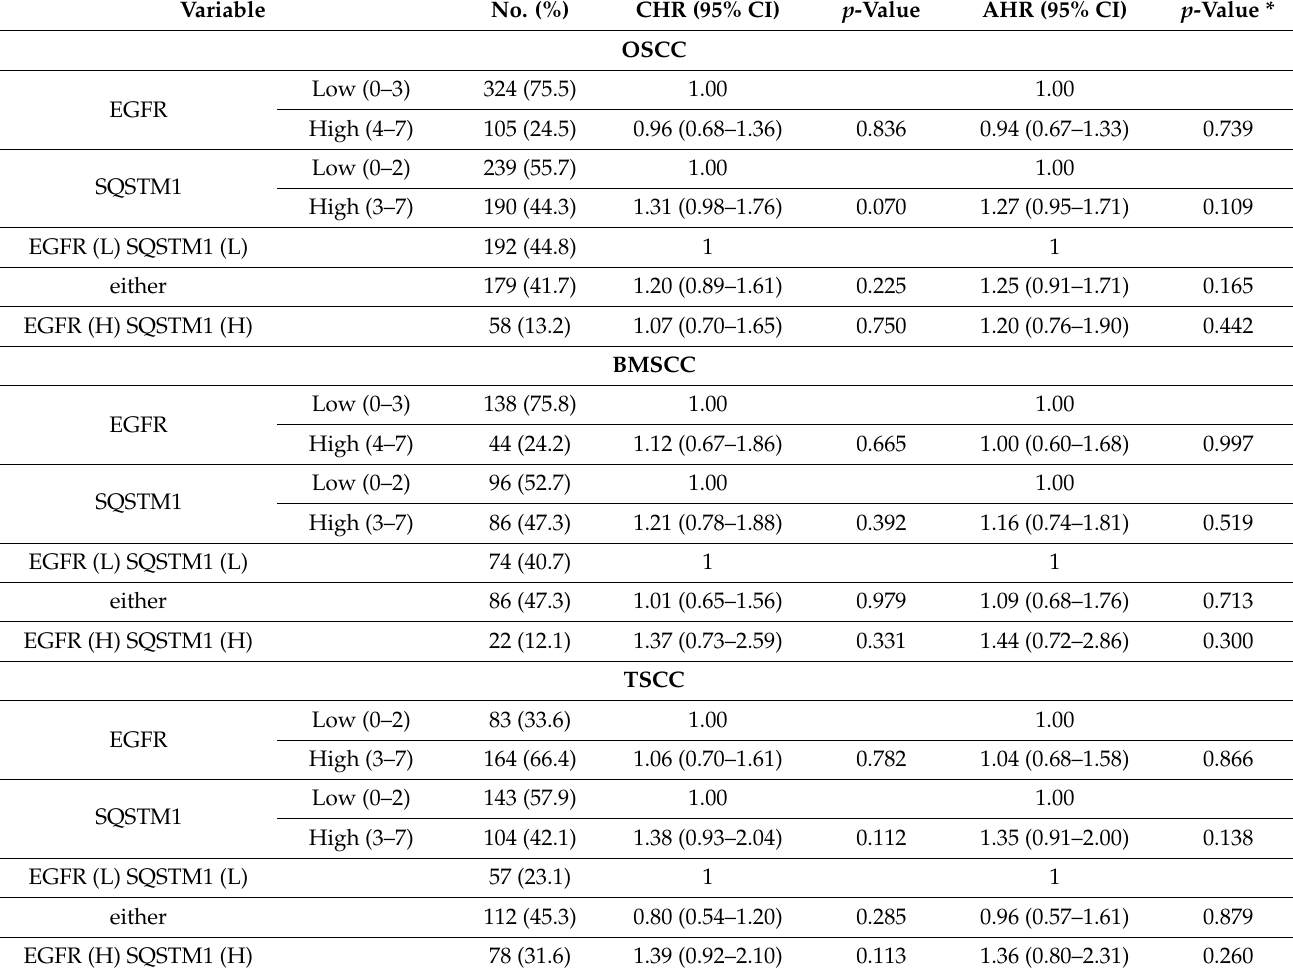
Table 3. The co-expression of EGFR and SQSTM1 in disease-free survival of OSCC patients.